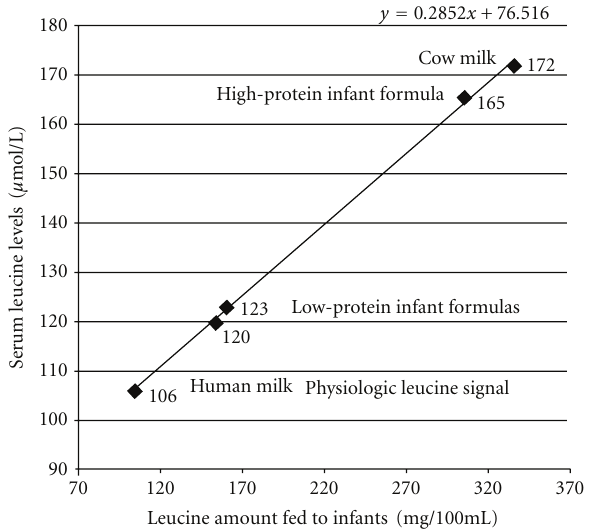
Figure 2: Linear correlation between oral leucine intake by the infant feeding and the infant’s serum leucine concentrations.